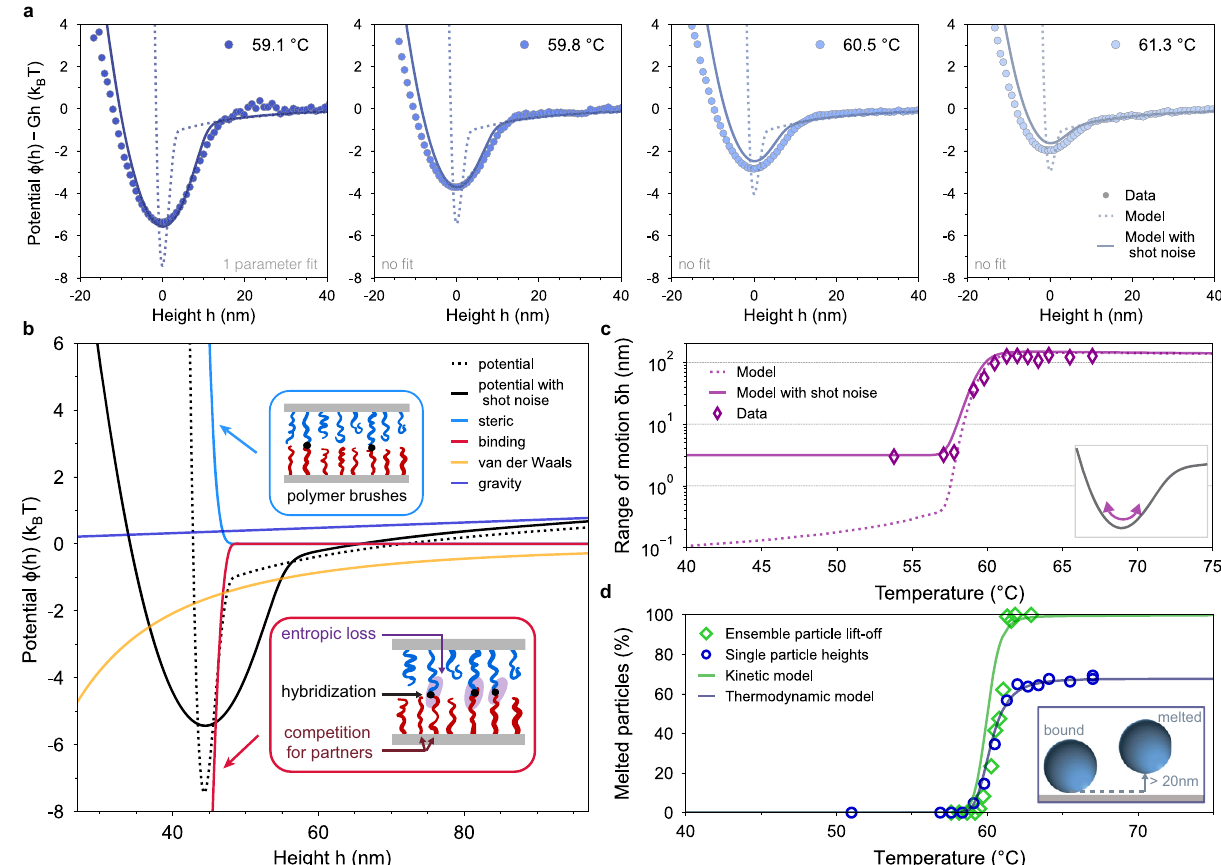
Fig. 2 Sticky polymer brush model reproduces experimental data. a Model and experimental potential pro fi les of the DNA-coated particle are presented in Fig. 1d with a measured coating density σ = 0.021 nm − 2 of 34k PEO with six sticky bases. The potential is shown at four temperatures around T m = 60.5°C. The density of strands on the glass ( σ g = 0.011nm − 2 ) is the only fi tting parameter and is fi tted only once at 59.1°C. No additional fi tting is done for higher temperatures. Shot-noise consistent with experimental measurements is applied to the model predictions. b , Contributions to the model potential pro fi le at = 2 59.1°C. (Insets) Schematics of components accounted for in the model. c Range of motion δ h ¼ h h 2 i 1 ϕ around the potential minimum, (inset) describing the typical displacement of the particle in the well (Supplementary Discussion Section 3.2.1). d Experimental and model thermodynamic and kinetic melting curves. The experimental kinetic curve corresponds to the ensemble particle lift-off also reported in Fig. 1e). To compute the kinetic melting curve we use the hindered diffusion of the free particle at height h ≃ 0.3nm above the hydrodynamic fl oor, D ⊥ ≃ D 0 ( h / a ) 59 where D 0 = 2.09 × 10 − 13 m 2 /s is the measured bare diffusion coef fi cient and 2 a = 5 μ m is the diameter of the particle. Both methods are insensitive to measurement noise (Supplementary Discussion Section 4.2). (Inset) The thermodynamic method measures the fraction of particles lifted at least 20nm above their equilibrium position.